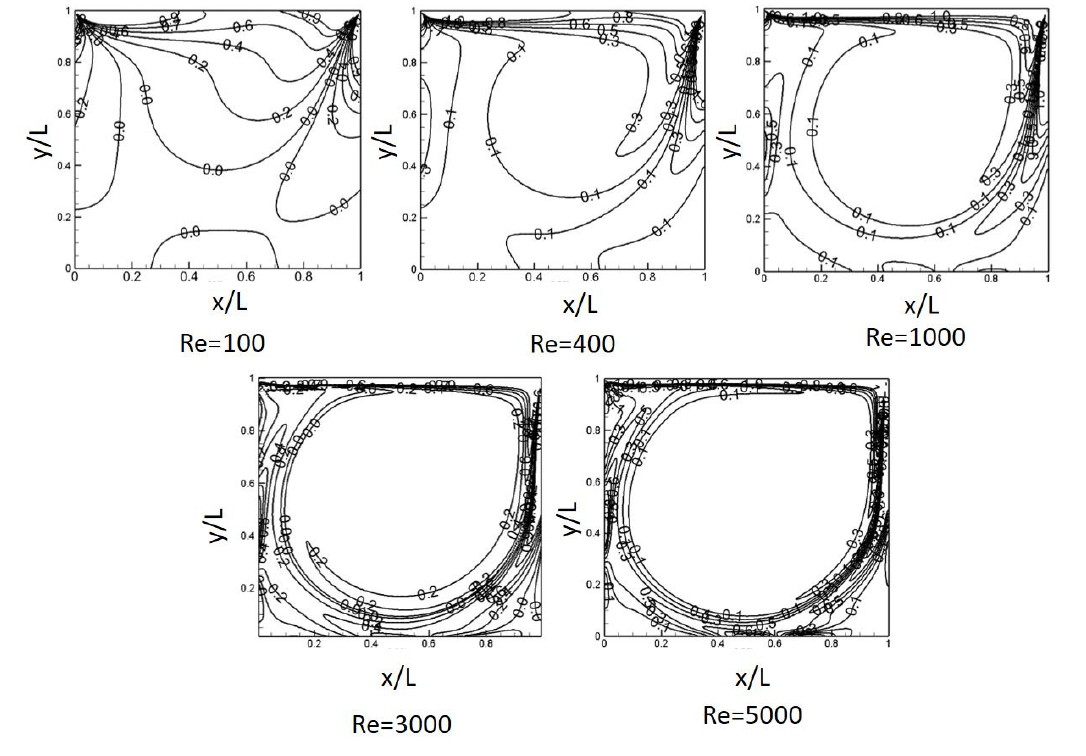
Figure 8. Vorticity contours for various Re.